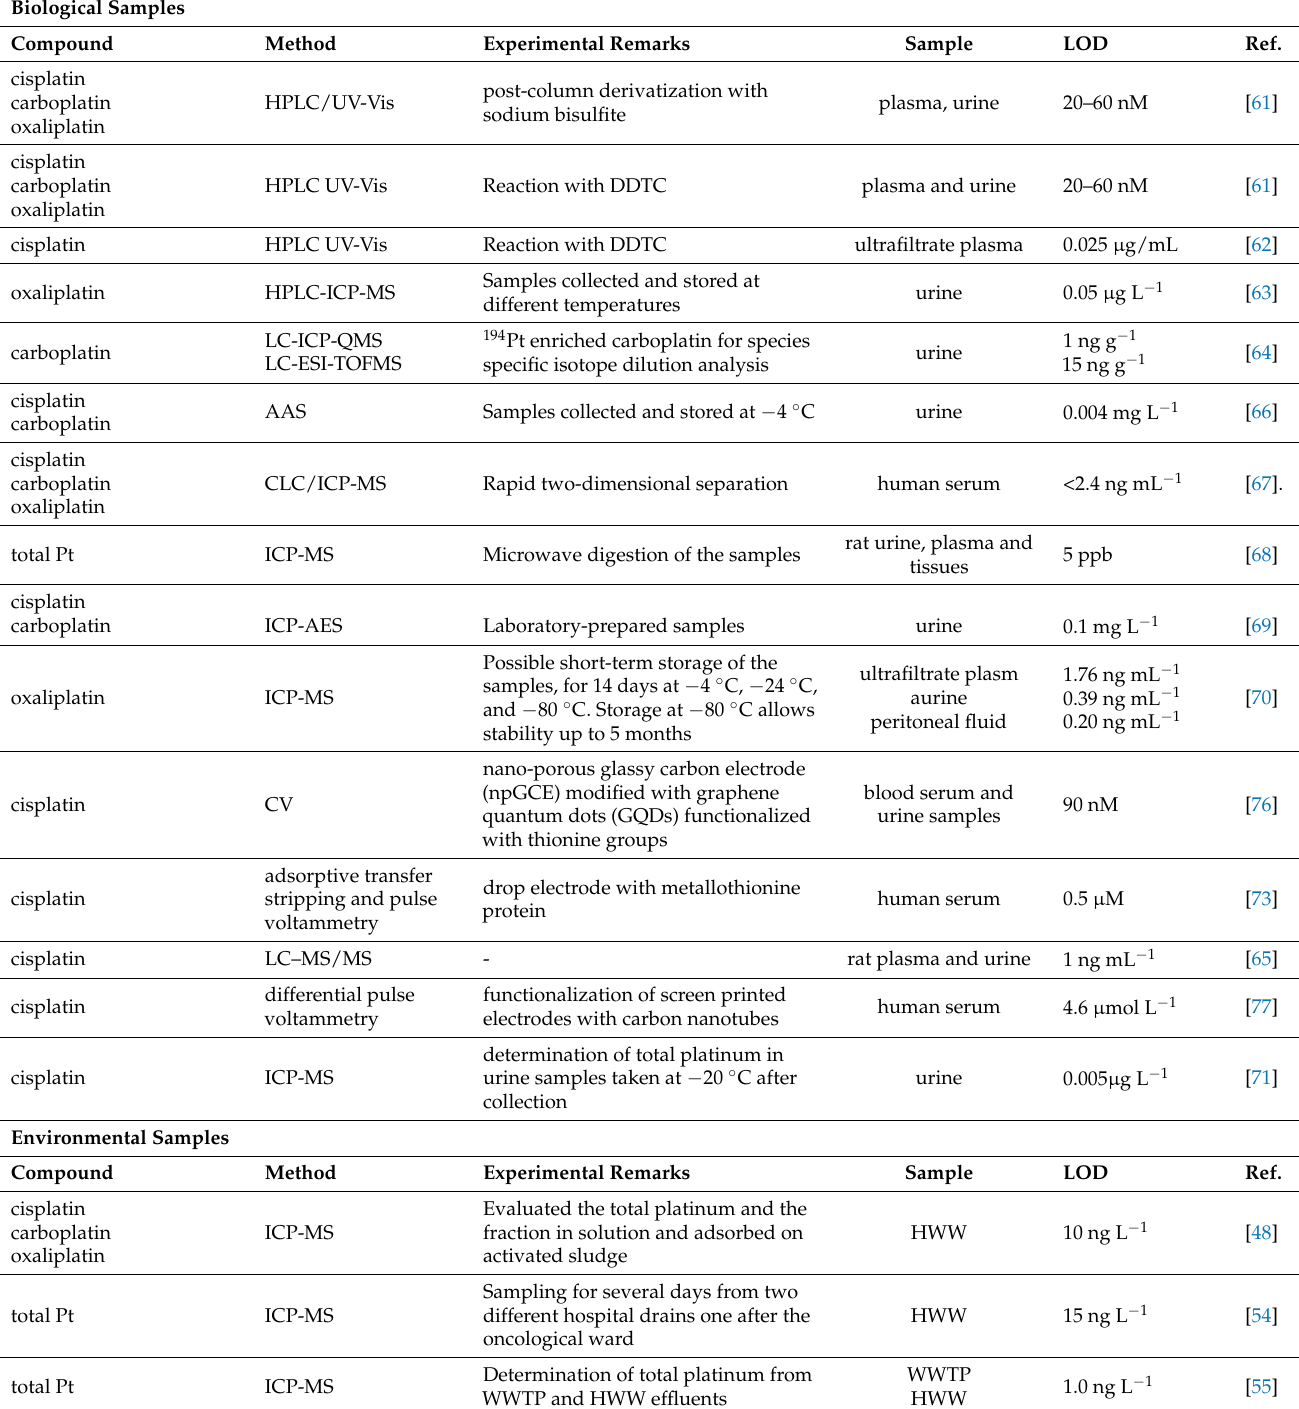
Table 2. Determination of Pt CDs in biological and environmental